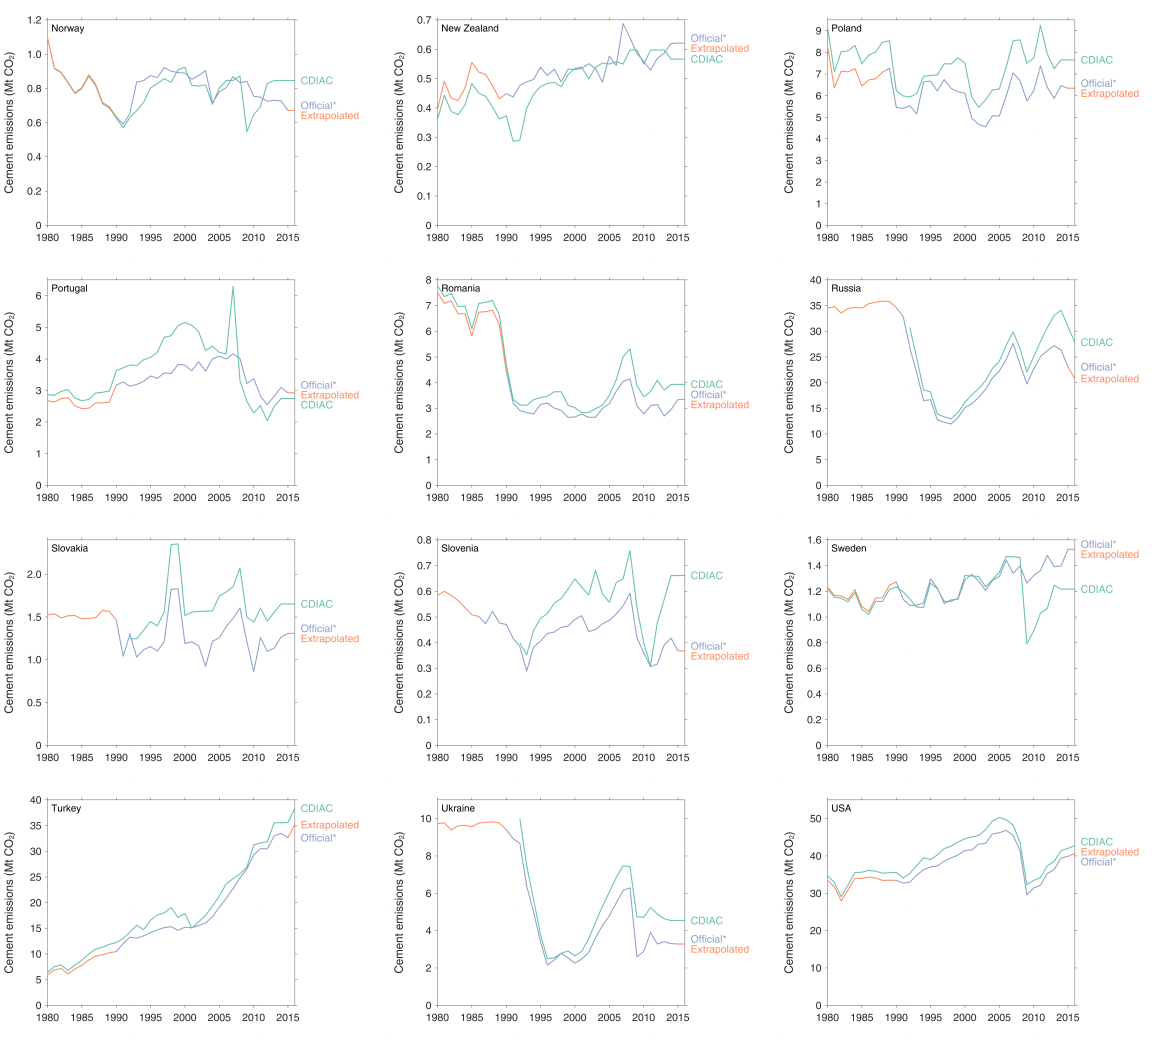
Figure D3. Revised cement emissions for Annex I parties to the UNFCCC.